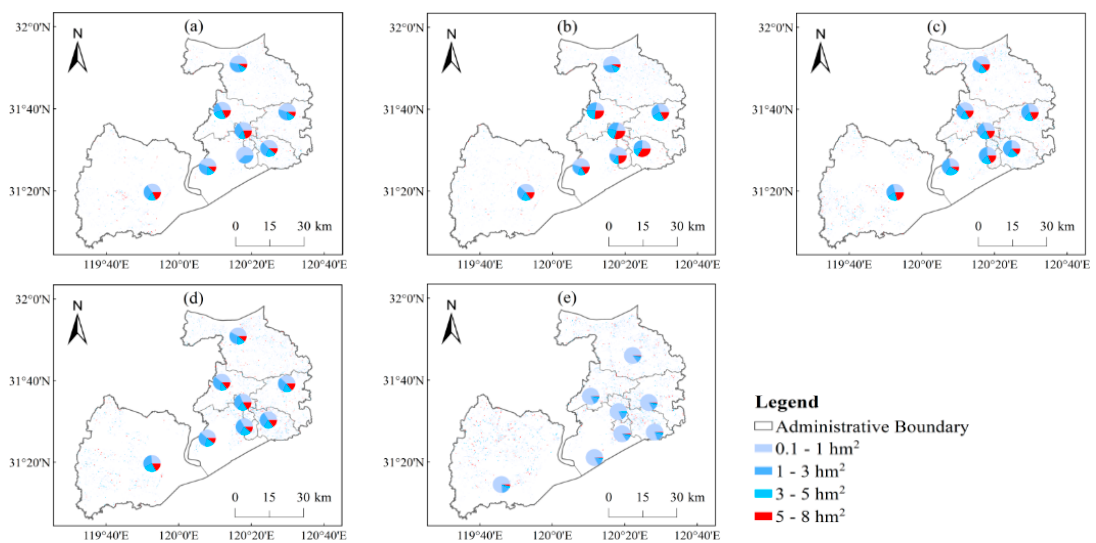
Figure 5. Changes in natural small and micro wetlands in Wuxi area from 1985 to 2020: 1985 ( a ), 1990 ( b ), 2000 ( c ), 2010 ( d ), 2020 ( e ). (The pie chart represents the area proportion of the four types of small and micro wetlands in each district).